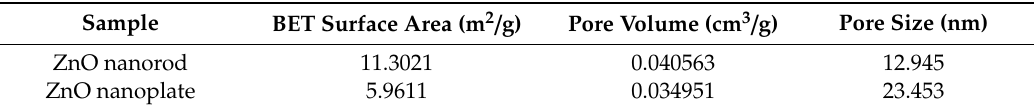
Figure 6. The Brunauer–Emmett–Teller (BET) surface area measured from N 2 adsorption and desorption isotherms at 77 K. Table 4. BET surface area and pore characteristics.